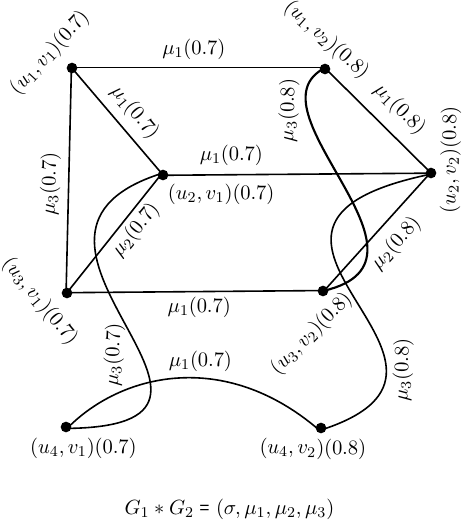
Figure 12. Maximal product of two fuzzy-graph structures Figure 12: Maximal product of two FGSs